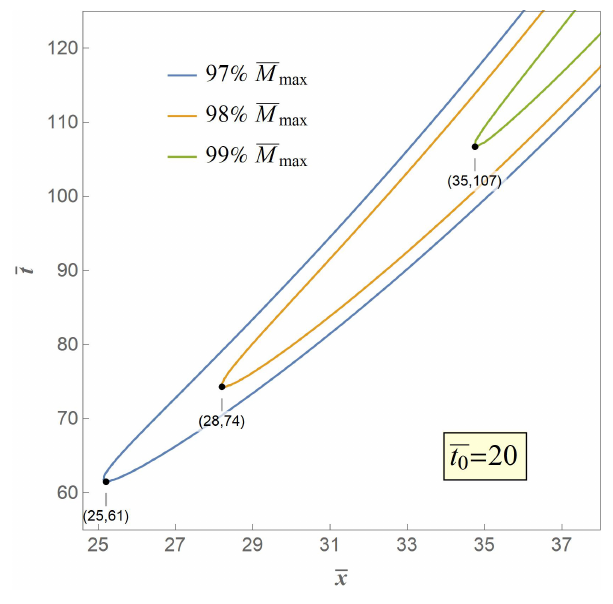
Figure 9. Contour curves when M = 97%,98%,99% M max at t 0 =